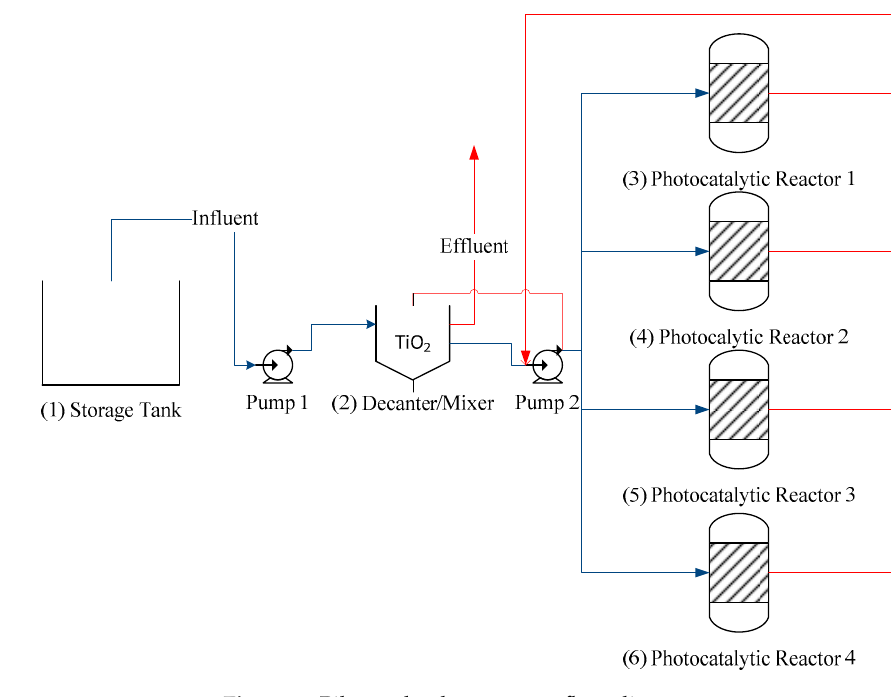
Figure 1. Pilot-scale plant process flow-diagram.